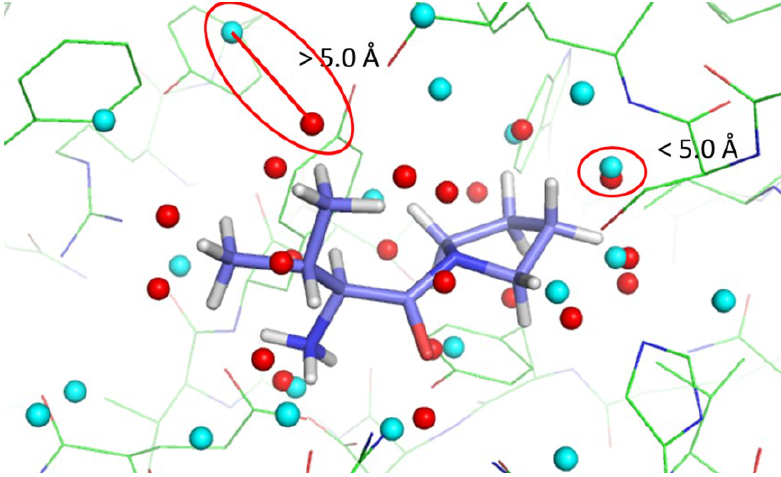
Figure 2. Definition of the success rate in determining correctly matched patches. For each protein–ligand complex structure, protein patches (cyan spheres) and ligand patches (red spheres) are generated. Using PL-PatchSurfer, all potential matching pairs were identified (examples of two potential matching pairs are shown in the red ellipses). Successful matches are defined as those where the distance between a paired ligand patch and a protein patch is within a cutoff distance.